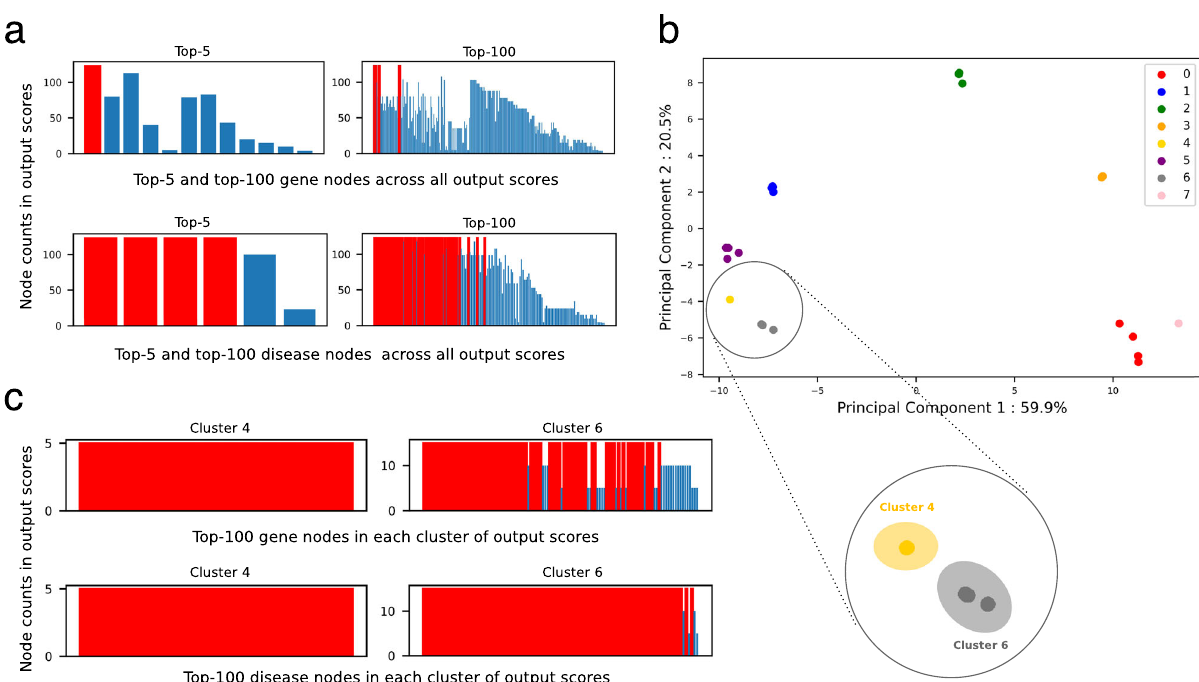
Fig. 4 Exploration of multiXrank parameter space. a Comparison of the top-5 and top-100 nodes ranked by MultiXrank using a biological multilayer networks composed of the gene multiplex network and the disease monoplex network for 125 different sets of parameters. The top-5 or top-100 ranked nodes for each set of parameters are merged, and the number of occurrences of each node are counted. The nodes are represented in bars colored in red when the node is found in all top-5 or top-100 scores, and in blue otherwise. b Clustering in the Principal Component Analysis (PCA) space of the output scores obtained with MultiXrank on the biological multilayer network composed of the gene multiplex network and the disease monoplex network using 125 different sets of parameters. The zoom-in emphasizes the clusters number 4 and 6. c Comparison of the top-100 nodes retrieved for the sets of parameters belonging to clusters 4 and 6 de fi ned in ( b ). The bar is colored in red when a node is found in all top-100 scores, and in blue otherwise. The parameters of the Random Walk with Restart (RWR) are detailed in Supplementary Table